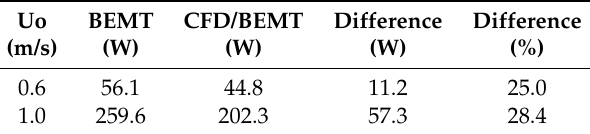
Figure 5. Rotor Power for ( a ) Uo = 0.6 m/s and ( b ) Uo = 1.0 m/s. Table 5. Average turbine rotor power.